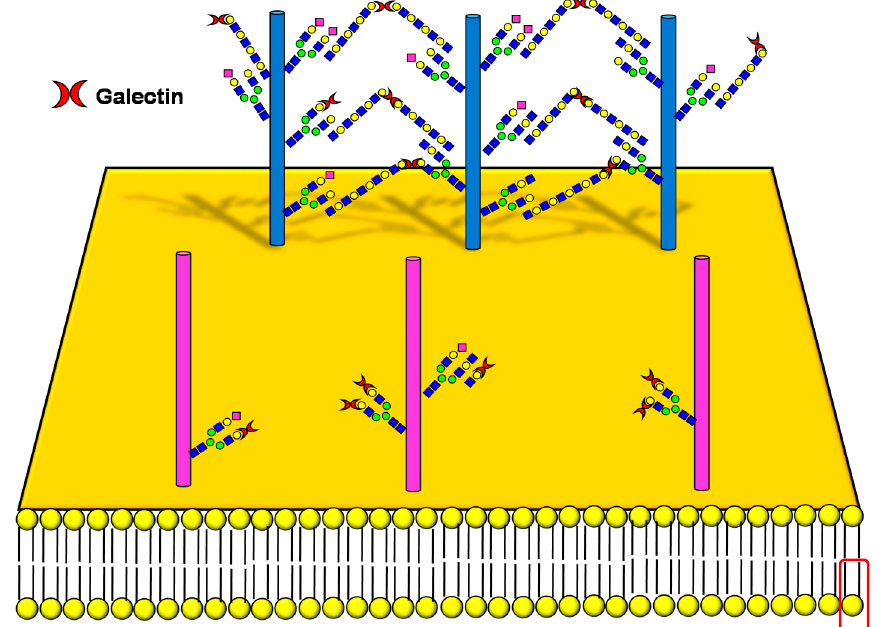
Figure 1. Schematic representation of a plasma membrane area with two different generic growth factor receptors. In light blue is represented a receptor with a high number of N -linked chains bearing the β 1,6-branched polylactosaminic chains, which are ideal ligands for galectins (in red). The binding of galectins to polylactosaminic chains results in a lattice, which stabilizes receptors on the cell membrane. In pink is represented a receptor with a small number of N -linked chains with a few β 1,6-branching and no polylactosaminic chains. This type of glycosylation makes galectins unable to form a lattice and stabilize receptors. Sugar codes are as in the legend of Table 1.